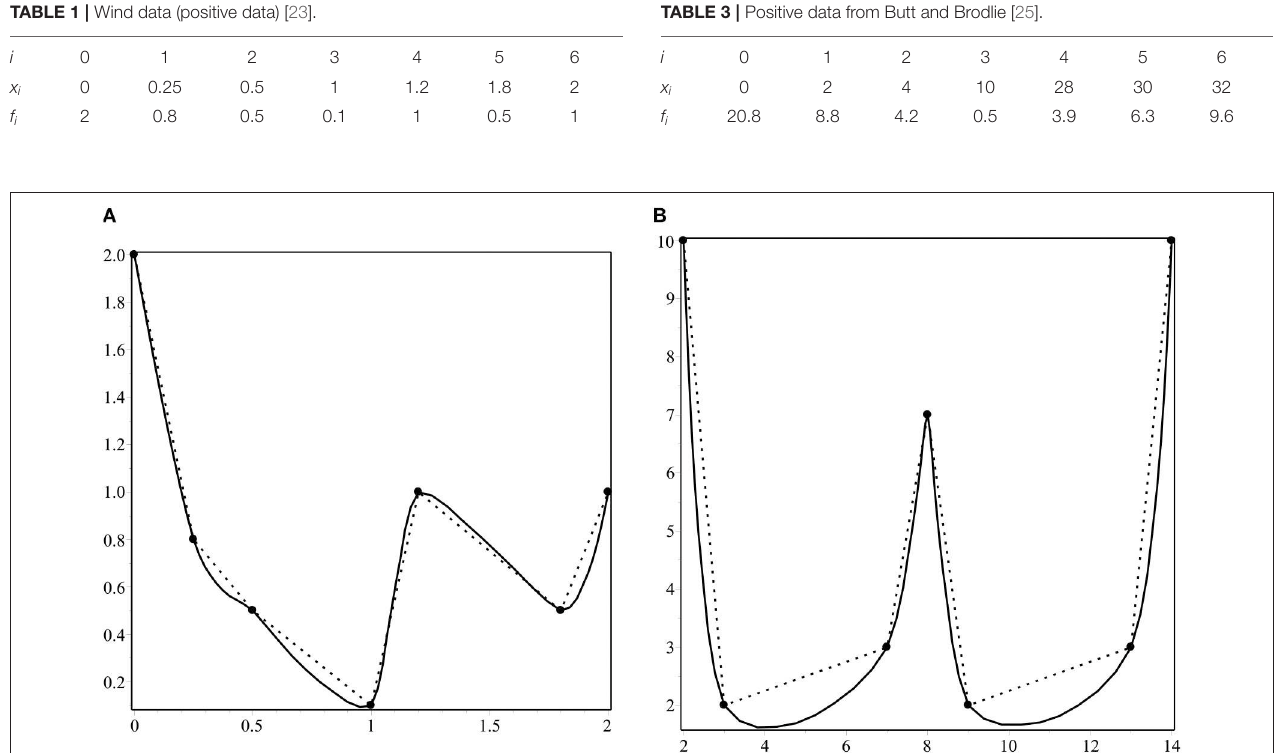
FIGURE 2 | The positivity-preserving curves generated by the four-point scheme (1) for positive initial data.